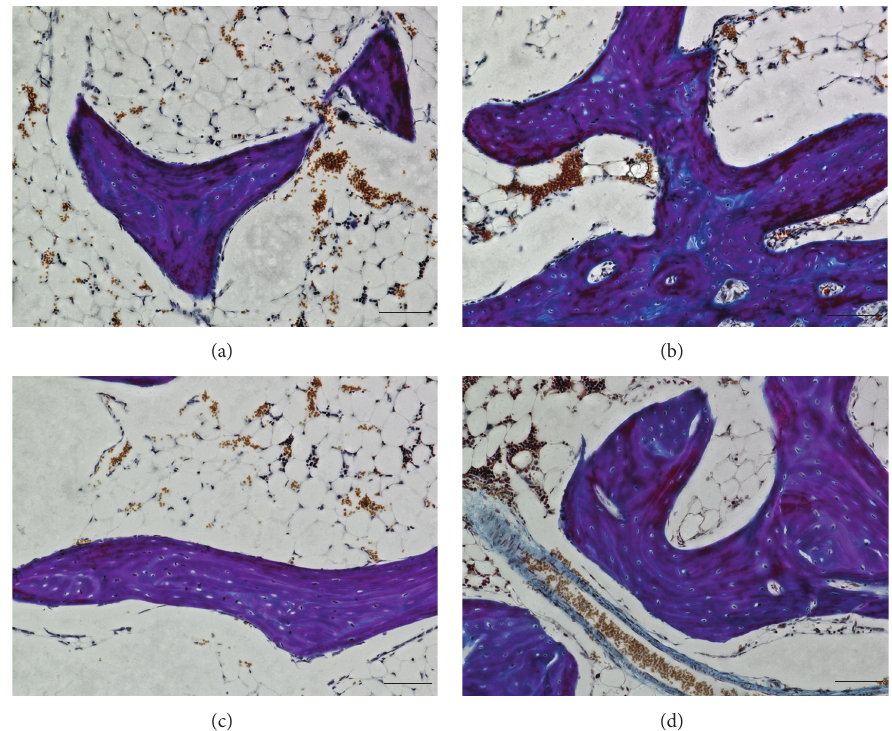
Figure 1: Ladewig stained sagittal sections of the femoral head. Methylprednisolone treatment induces osteonecrosis demonstrated by an increase of empty osteocyte lacunae (c) in comparison to PBS treated control animals (a and b). Enoxaparin cotreatment leads to a decrease of empty osteocyte lacunae and adipocytes (d). Bar represents 100 𝜇 m.